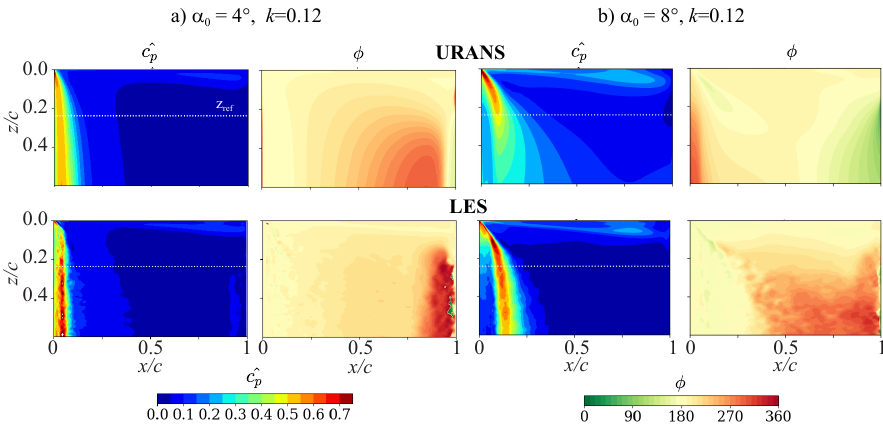
Figure 8. Unsteady surface pressure amplitude ˆ C P and phase φ as predicted by URANS and LES on the suction side. Oscillation frequency: k = 0.12. Pitching axis at x / c = 0.46; ( a ) α 0 = 4 ◦ , ( b ) α 0 = 8 ◦ .